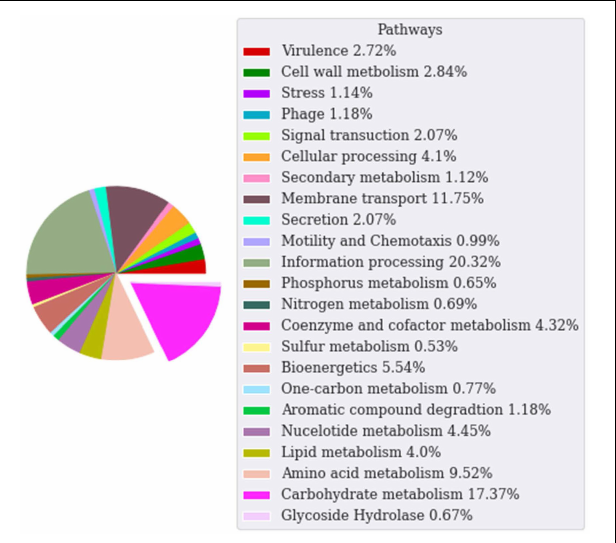
FIGURE 1 | Pie chart of ERGO annotations for Geobacillus sp. WSUCF1 bacterial strain categorized based on the pathway they participate in. Each wedge in the pie chart represents the percentage of annotations for that pathway. The carbohydrate and glycoside hydrolase enzymes are grouped together.